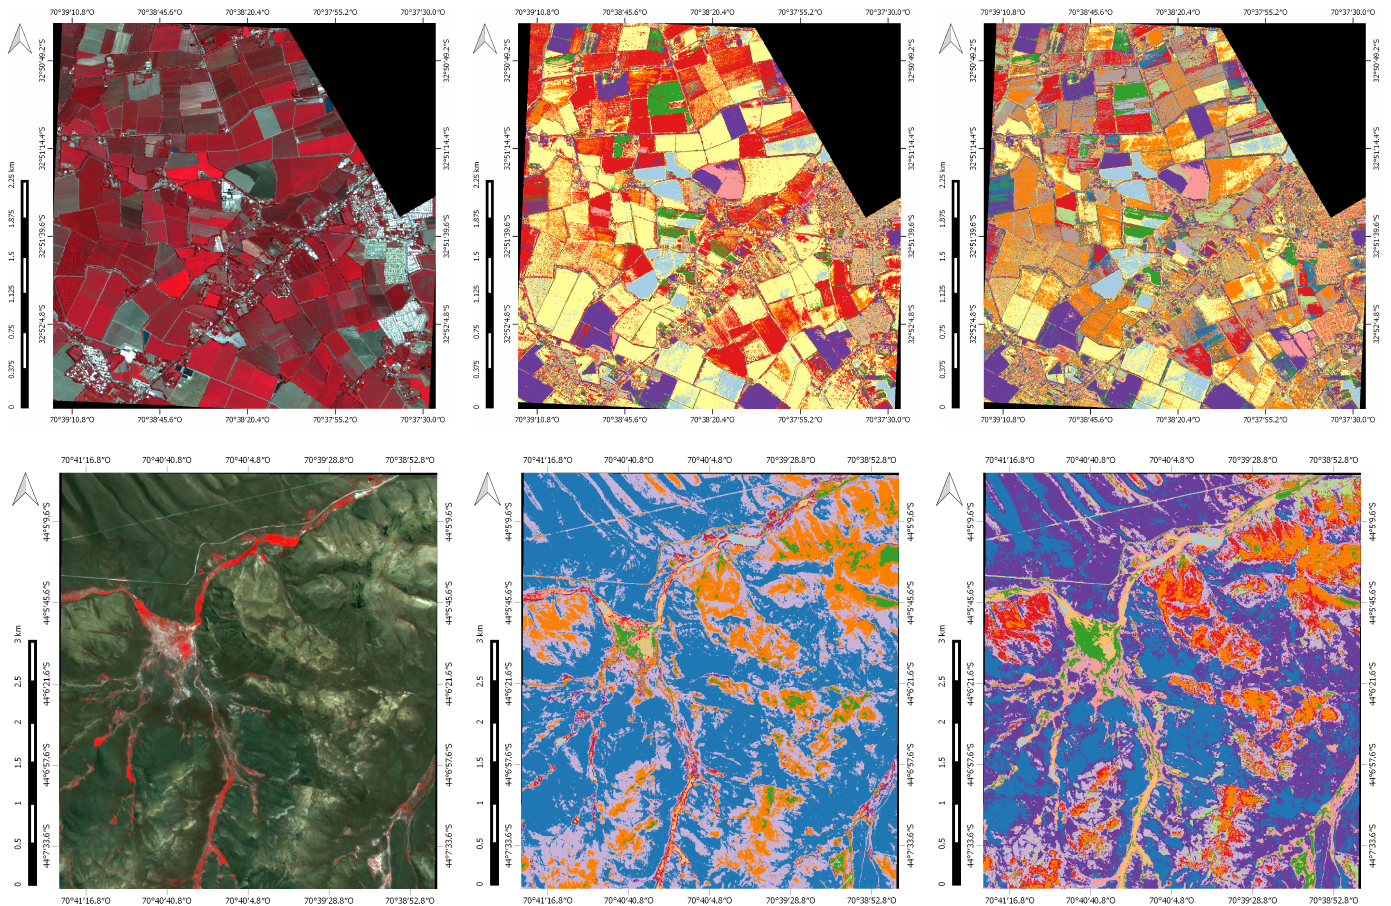
Figure 5. Region-merging methods’ comparison; results for image CHILE2 (15 final spectral clusters) are displayed in the upper row and for ARGENTINA (10 final spectral clusters) in the lower row. First column: false color composite NIR-G-R. Results for the color distance region-merging method and co-occurrence in superpixels region-merging method are displayed in the second and third column, respectively. Colors have no special